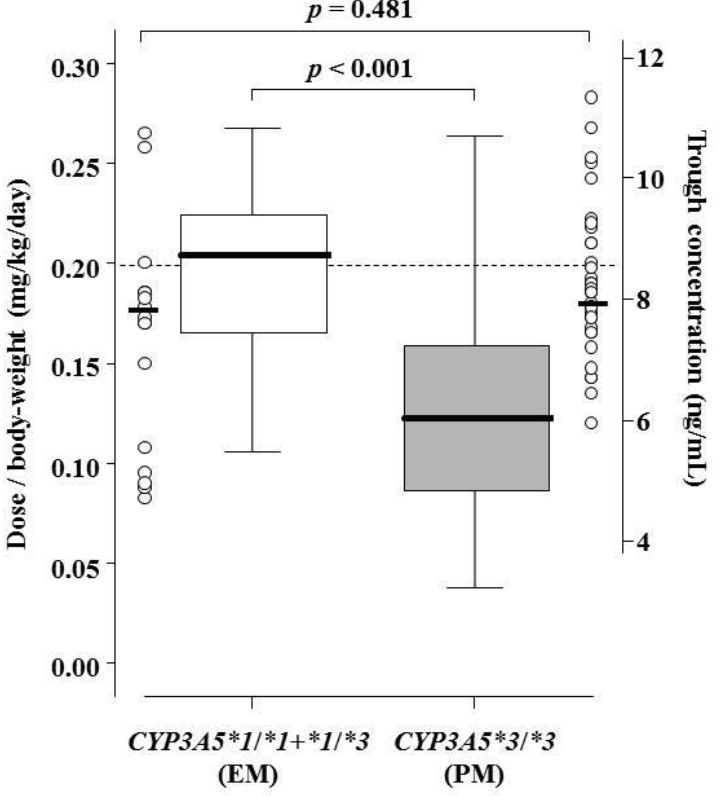
Figure 4. Comparison of body weight-adjusted dosage and trough concentration (open circles) of tacrolimus on Day 28 after surgery between CYP3A5 EM and PM patients. Graphical analysis was performed using an SPSS box and whiskers plot. The box spans data between two quartiles (IQR), with the median represented as a bold horizontal line. The ends of the whiskers (vertical lines) represent the smallest and largest values that were not